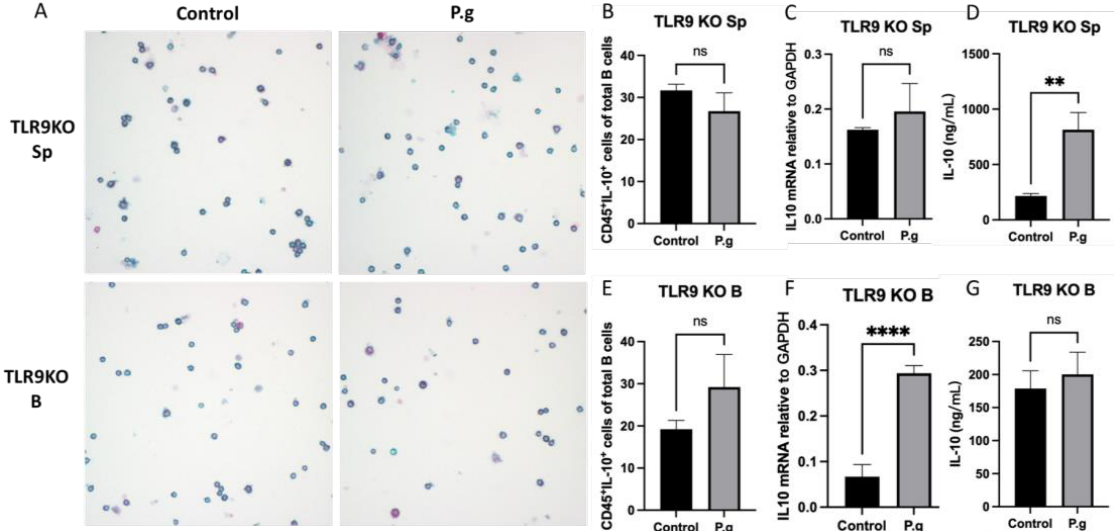
Figure 2. Under P. gingivalis stimulation for 24 h, the CD45 + IL-10 + cells, IL-10 mRNA level and se- creted IL-10 protein levels of splenocytes and B cells isolated from pre-immunized TLR9 knockout mice were calculated. ( A ) The representative ICC images of CD45 + IL-10 + cells in each group. CD45 cells were labeled with rat anti-mouse CD45 antibody conjugated with emerald anti-rat antibody (blue) and IL-10 were labeled with goat anti-mouse IL-10 antibody conjugated with permanent red anti-goat antibody (red). ( B , E ) The percentage of CD45 + IL-10 + cells among splenocytes ( B ) and B cells ( E ) were calculated based on cell immunocytochemistry staining. ( C , F ) The IL-10 mRNA ex- pression in splenocytes ( C ) and B cells ( F ) was analyzed by quantitative RT-PCR. ( D , G ) The secreted IL-10 protein levels in the supernatants were measured by a mouse IL-10 enzyme-linked ELISA kit using a 1:10 assay diluent in PBST. The data were shown as mean ± SD; significance calculated by unpaired t -test was indicated as ** p < 0.01, **** p < 0.0001, and ns (no significant difference) as p > 0.05 (n = 5).